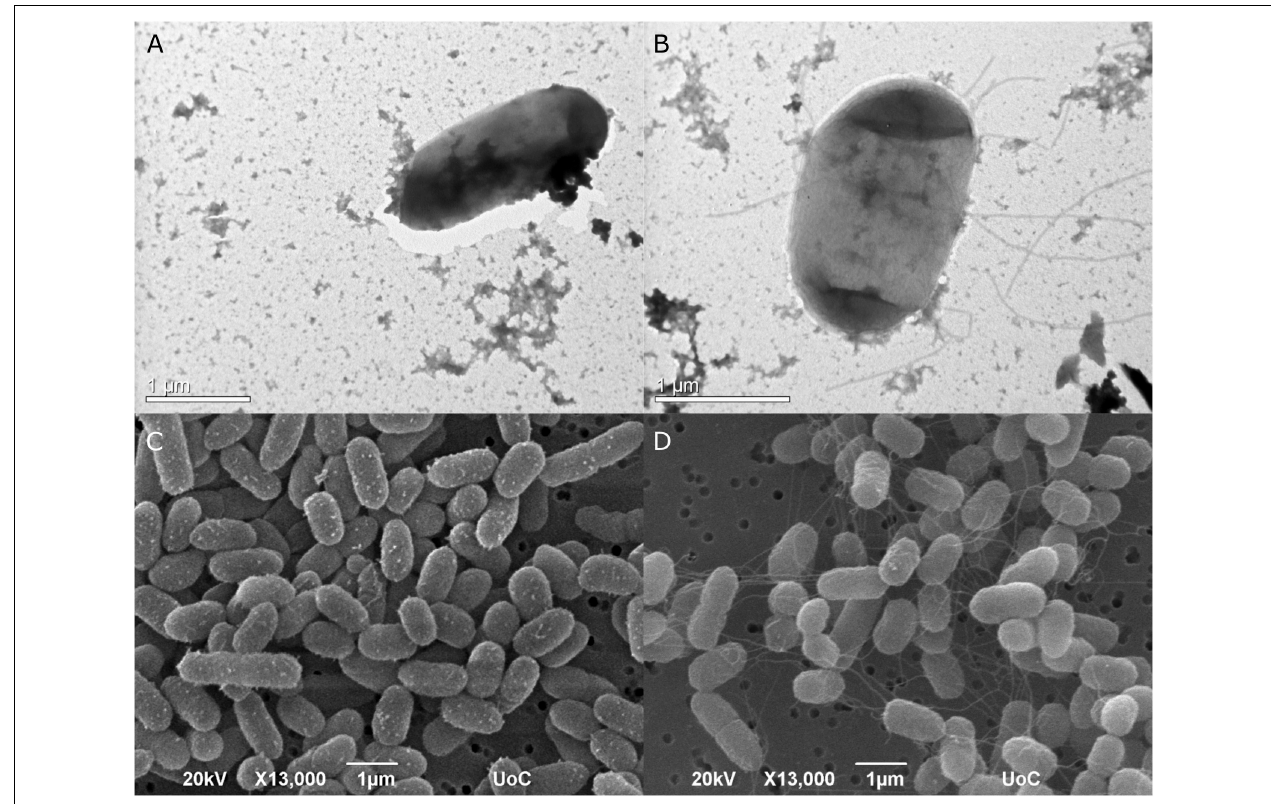
FIGURE 5 | Transmission photomicrographs of negatively stained E. anguillarum . Strain EA011113 on the left where flagella are absent (A) , and the type strain of E. anguillarum , ET080813 bearing numerus peritrichous flagella (B) . Below: SEM photomicrographs of EA011113 (C) and ET080813 (D) .